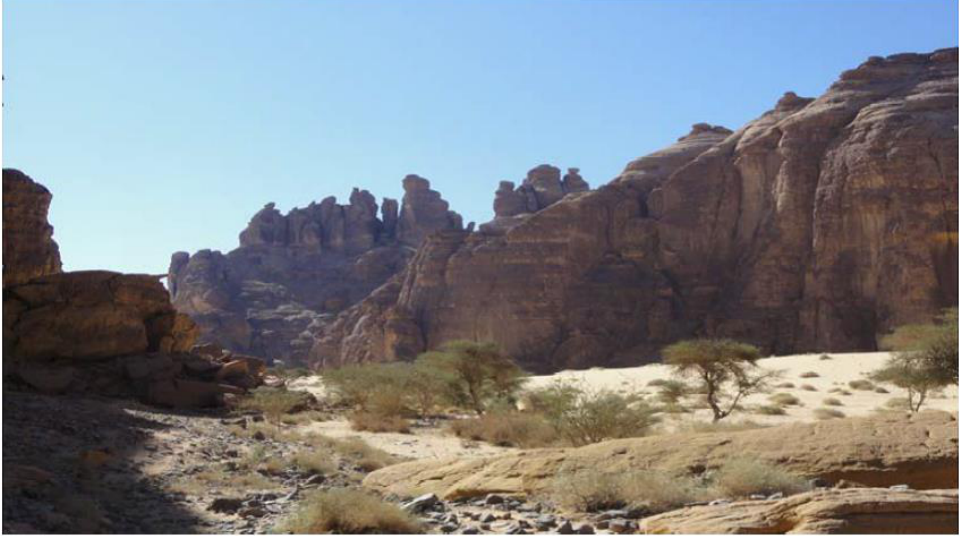
Figure 13. Some of the rock art sites are located in isolated desert places.